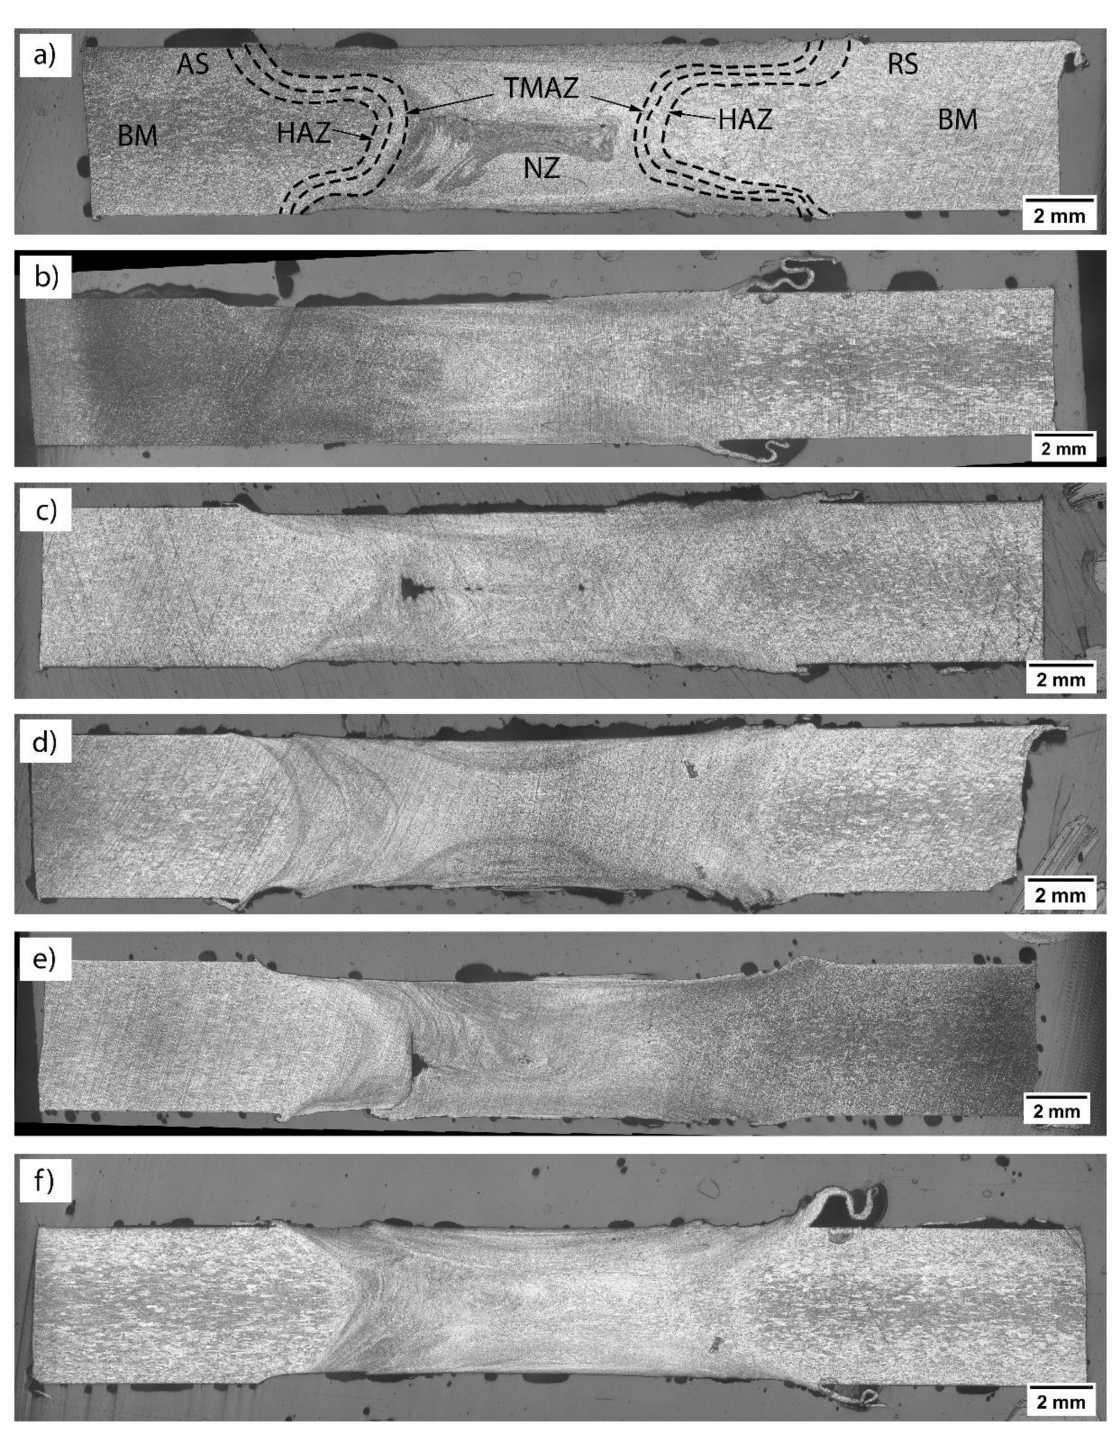
Figure 6. Cross-sectional macrographs of specimens: ( a ) A2-1; ( b ) A2-2; ( c ) A2-3; ( d ) A4-1; ( e ) A4-2; and ( f )